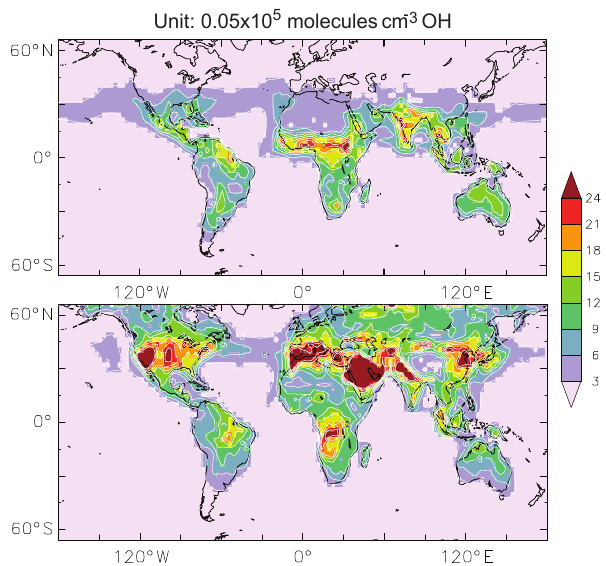
Figure 2. Nighttime OH in the boundary layer in January (top) and July (bottom). Color coding is the same as Fig. 1, but concentrations are scaled by a factor of 20 ( × 0 . 05 × 10 5 moleculescm − 3 )